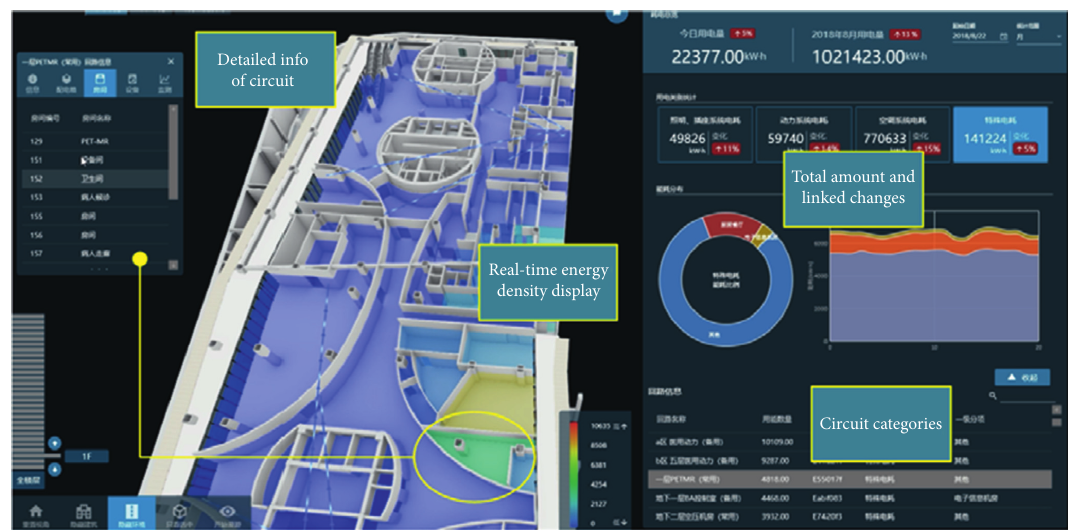
Figure 7: Core functions of visual energy management.